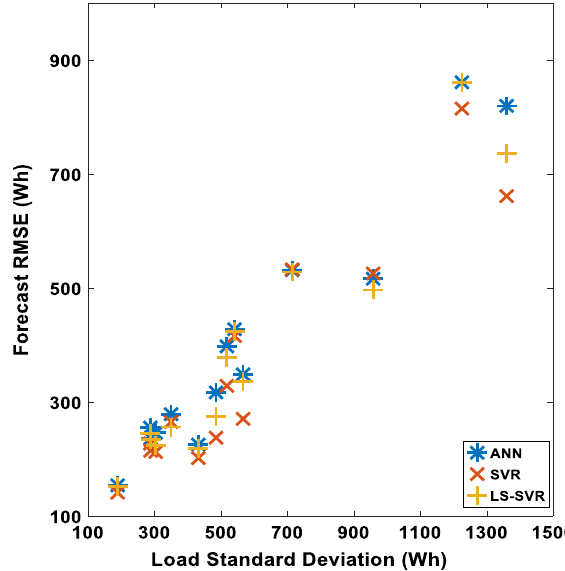
Fig. 2. Forecast RMSE performance of the models vs. household load standard